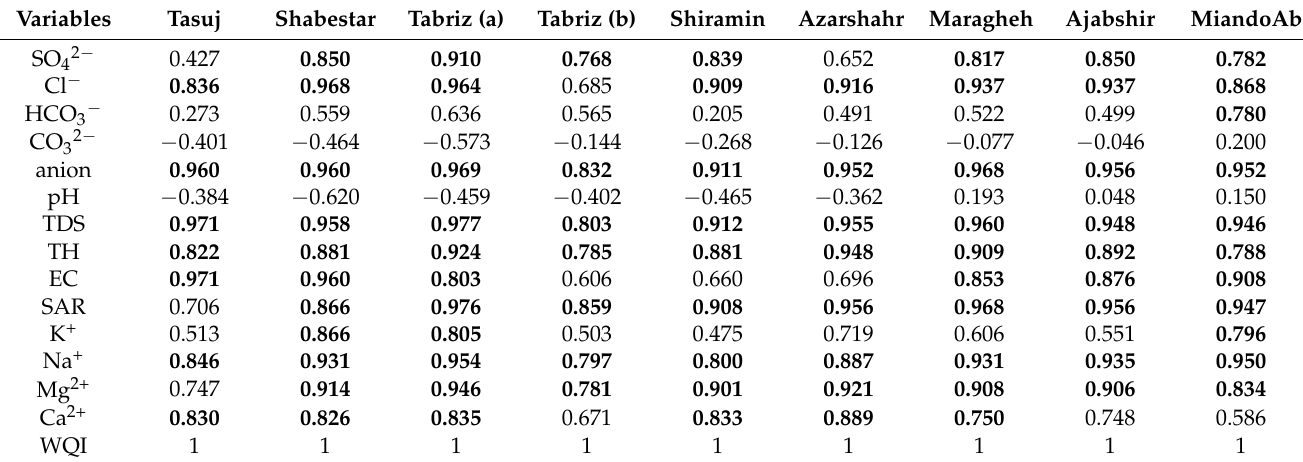
Table 3. Spearman correlation results between WQI and